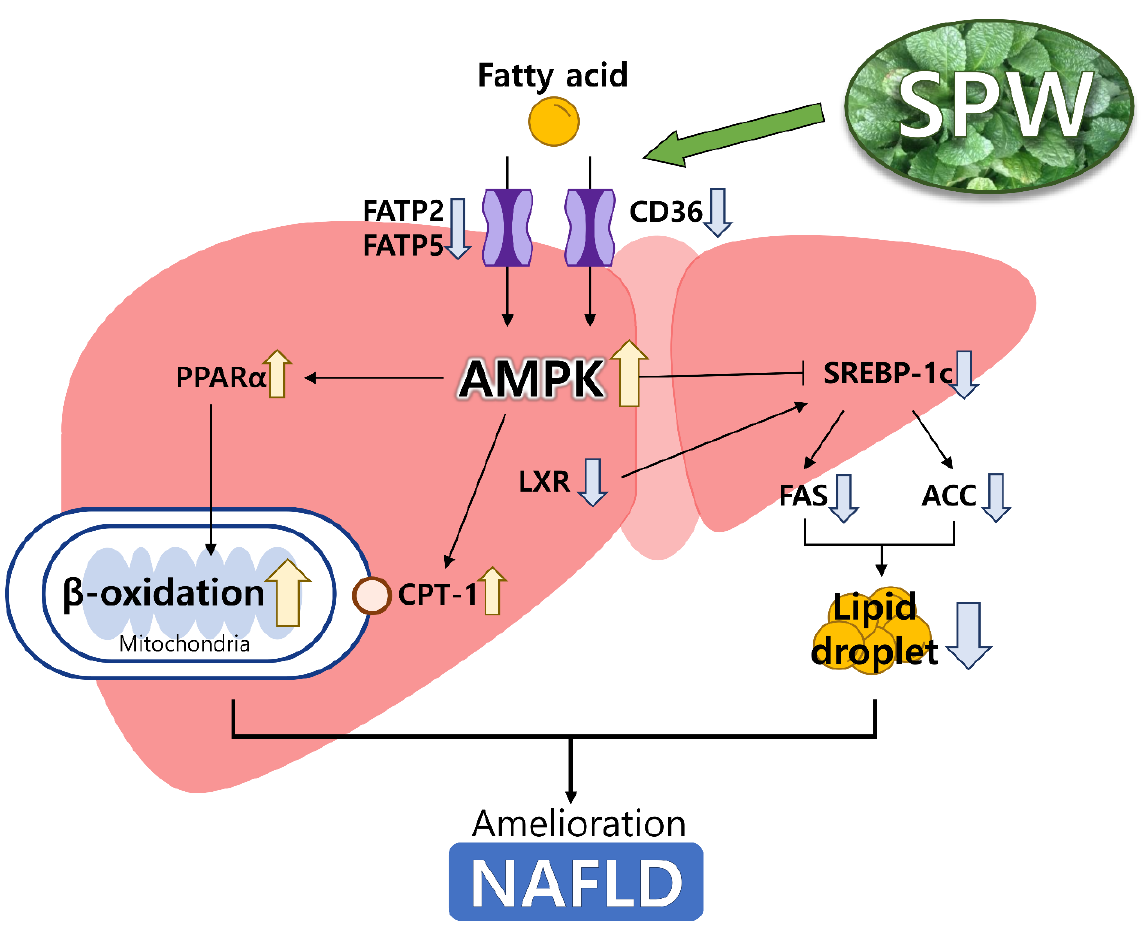
Figure 6. Scheme for NAFLD pathway in the liver. Yellow arrows were meant up-regulated the expression and blue arrows were meant down-regulated the expression.